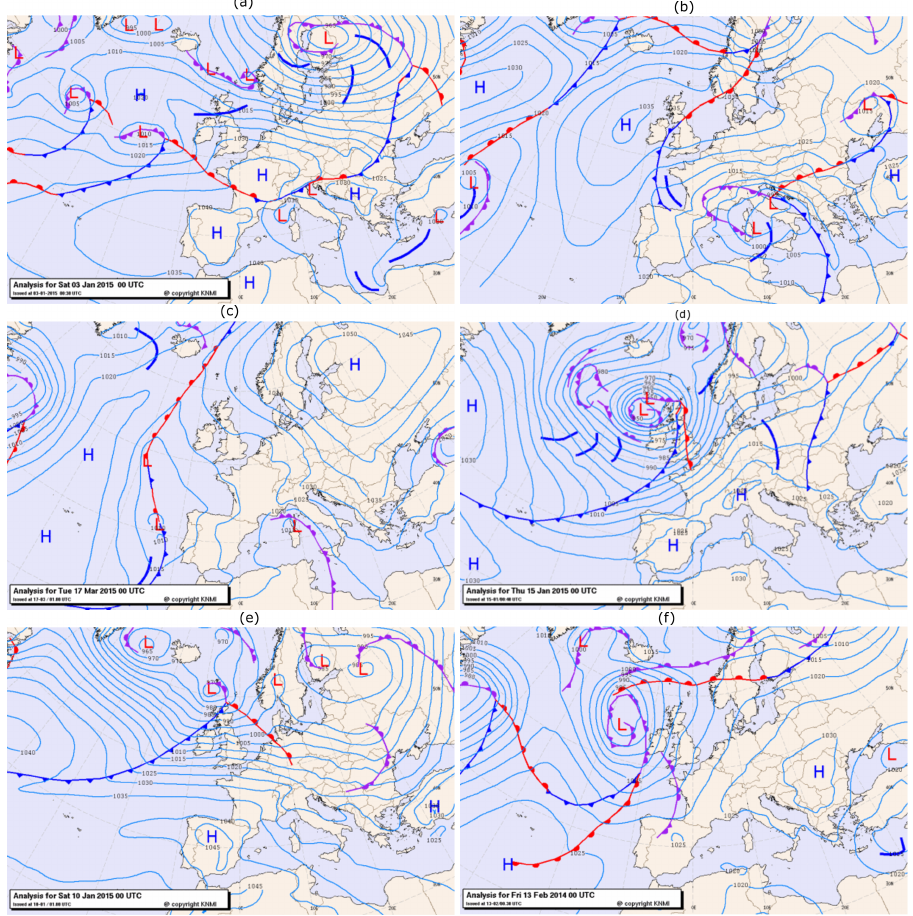
Figure 5. KNMI synoptic charts (https://www.knmi.nl, accessed on 5 May 2021) corresponding to the six most common SOM-based weather patterns at 00:00 UTC on: ( a ) 3 January 2015 ( a 1), ( b ) 6 February 2015 ( e 1), ( c ) 17 March 2015 ( f 1), ( d ) 15 January 2015 ( a 5), ( e ) 10 January 2015 ( b 5), and ( f ) 13 February 2015 ( f 5). The prominent synoptic features are shown: L (low pressure), H (high pressure), blue (cold front), red (warm front) and magenta (occluded